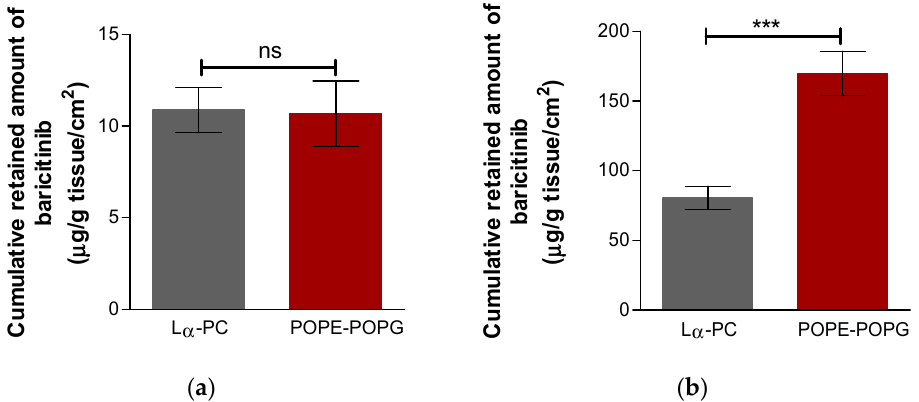
Figure 9. Baricitinib amount retained in the tissues: ( a ) cornea ( b ) sclera. Results are expressed as mean ± SD (n = 5). L α -PC = L- α -phosphatidylcholine; POPE:POPG = 1-palmitoyl-2-oleoyl-phosphatidylethanolamine: 1-Palmitoyl-2-oleoyl-sn-glycerol-3-phosphoglycerol (3:1, mol/mol). t -Test analysis with a statistically significant difference: *** = p < 0.0001; ns = non-significant.